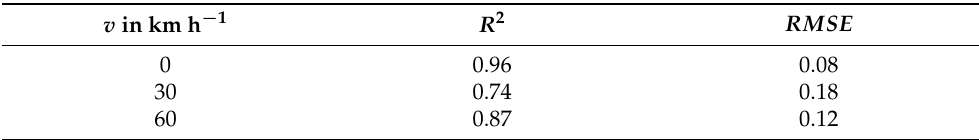
Table 4. Goodness-of-fit parameters for the logistic regression at the three different driving speed lev- els ( R 2 : Coefficient of determination, RMSE : Root mean squared error). The determined parameters confirm the psychometric relationship between the roadway luminance and the relative frequency of “bright” or better ratings as a function of driving speed. v in km h − 1 R 2 RMSE 0 0.96 0.08 0.74 0.18 0.87 0.12